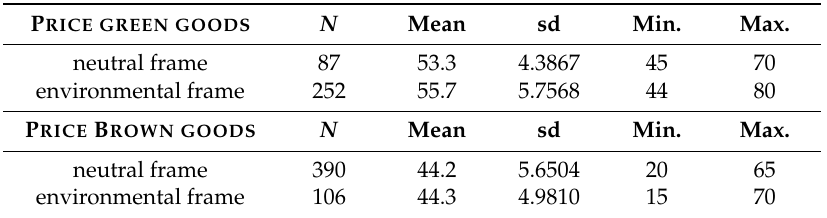
Table 5. Prices paid for green and brown goods in both